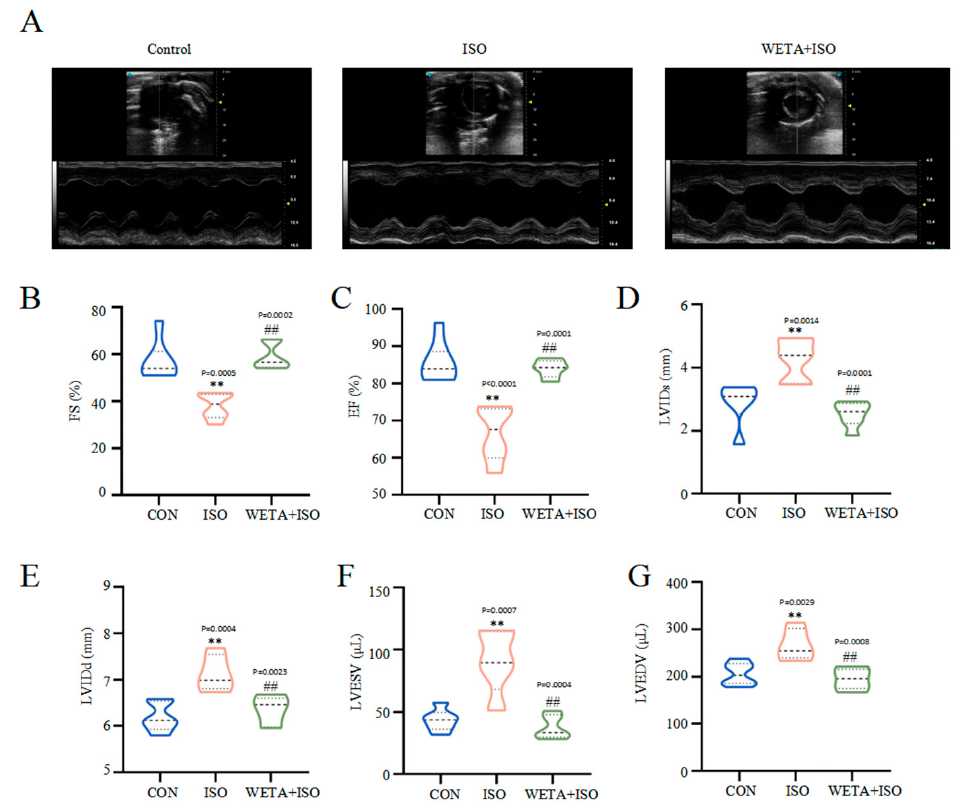
Figure 2. WETA improved LV echocardiography parameters in ISO-induced rats. ( A ) Representative short axis image of the LV, the levels of ( B ) FS, ( C ) EF, ( D ) LVIDs, ( E ) LVIDd, ( F ) LVESV, and ( G ) LVEDV. Values are mean ± SD (n = 6), ** p < 0.01 vs. CON group; ## p < 0.01 vs. ISO group, using one-way ANOVA.